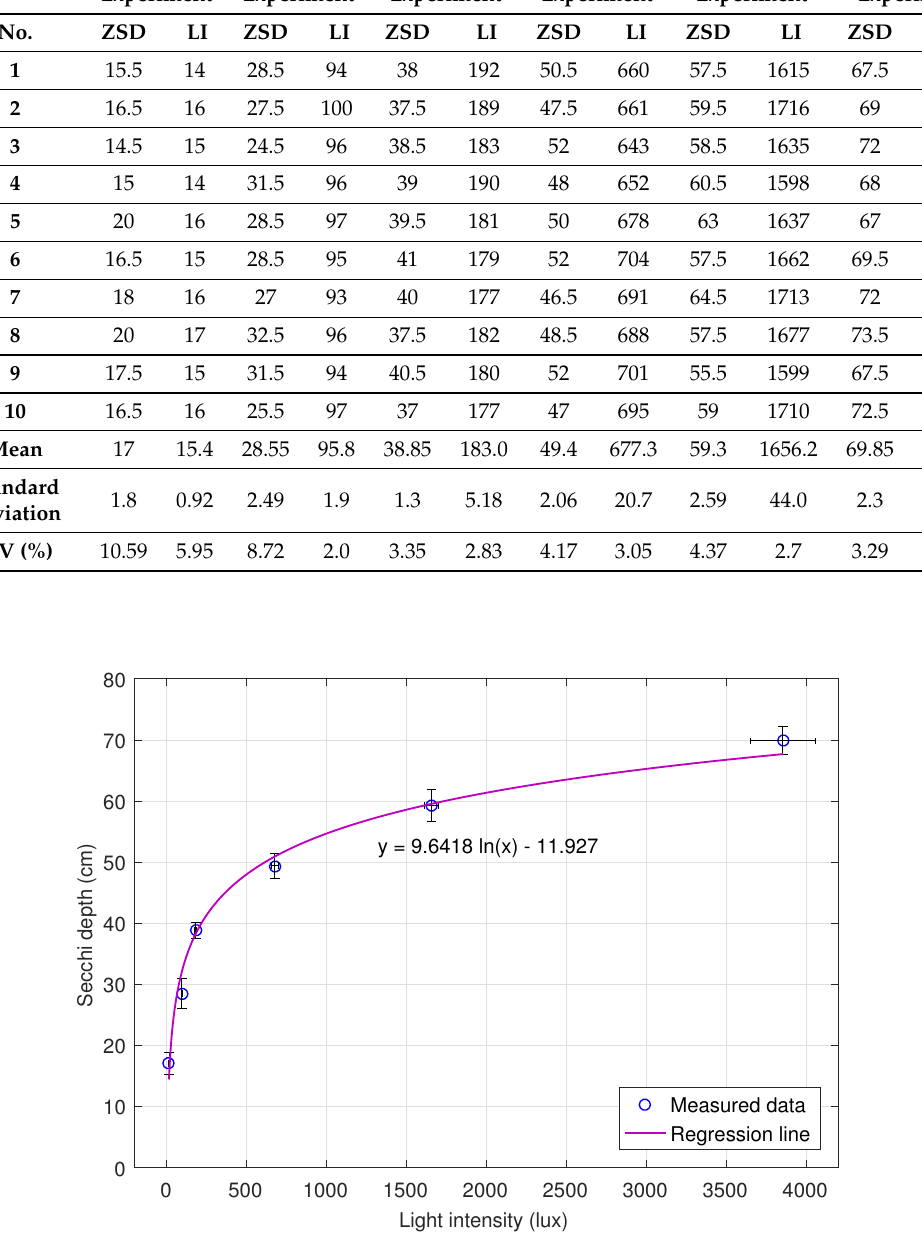
Figure 9. Regression line showing the relationship between Secchi depth and light